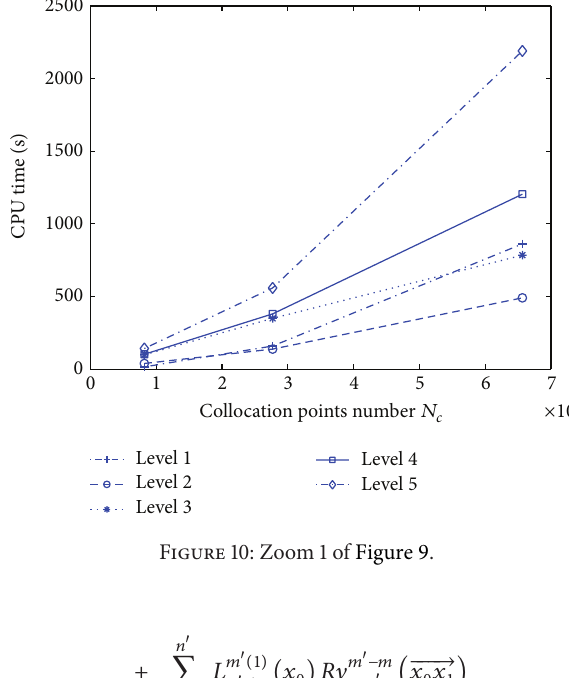
Figure 9: CPU time versus particles number for different levels.